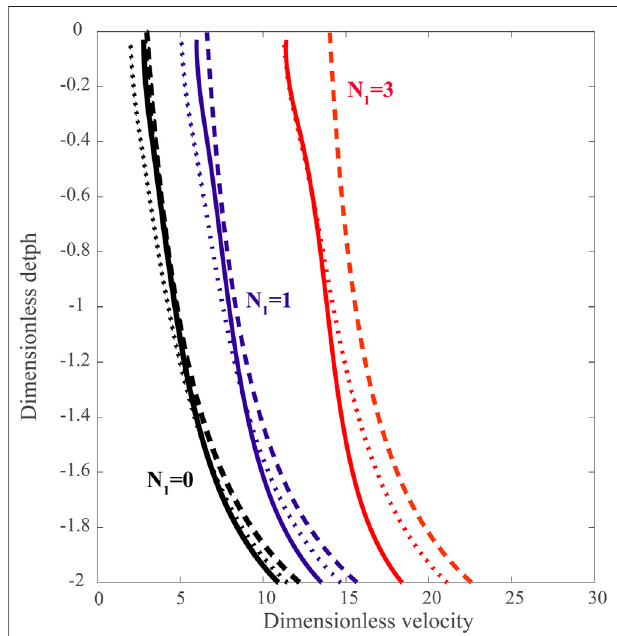
FIGURE 7 | Dimensionless velocities of a fl uid- fl uid fracture propagating along a given trajectory as a function of depth derived from the dynamic numerical model. Depth is normalized by the half-length of the load applied at the surface. All fractures start at X s and Z s corresponding to analog experiment EXP61 and dimensionless number N 2 is set to 0.35. Black, blue and red lines are, respectively, for dimensionless number N 1 equal to 0, 1 and 3. Plain lines are for velocities along the de fl ected path followed by the crack during experiment EXP61 considering the stress fi eld induced by the load applied at the surface, dotted lines are for velocities in absence of external stress fi eld along the de fl ected trajectory and dashed lines are for velocities along a vertical path without stress